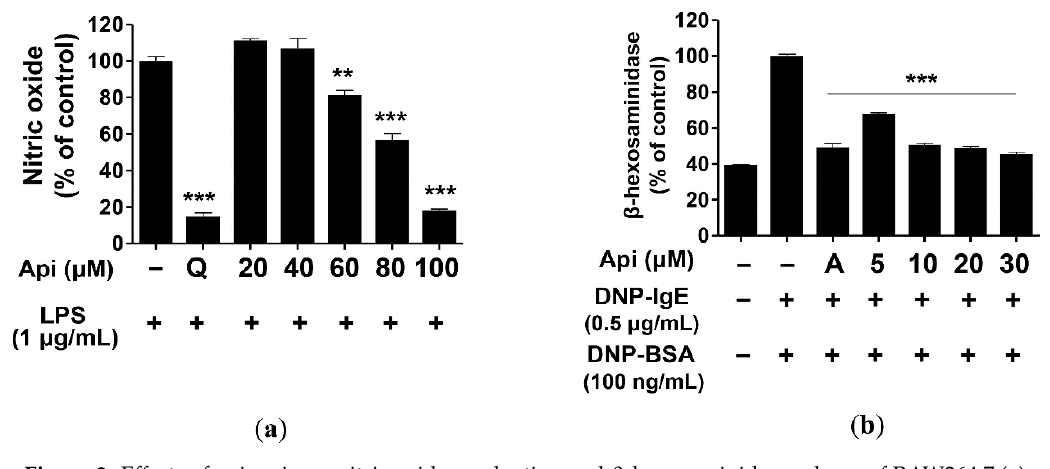
Figure 2. E ff ects of apigenin on nitric oxide production and β -hexosaminidase release of RAW264.7 ( a ) and RBL-2H3 cells ( b ), respectively. LPS- or IgE-induced cells were treated with various concentrations of apigenin (5, 10, 20, 30, 40, 60, 80, and 100 µ M). Api, apigenin; A, cyclosporine A (1 µ g / mL); LPS, lipopolysaccharide; Q, quercetin (15 µ M). The data were analyzed using one-way analysis of variance (ANOVA) followed by Tukey’s test. ** p < 0.01, *** p < 0.001 versus LPS-stimulated cells without apigenin treatment.